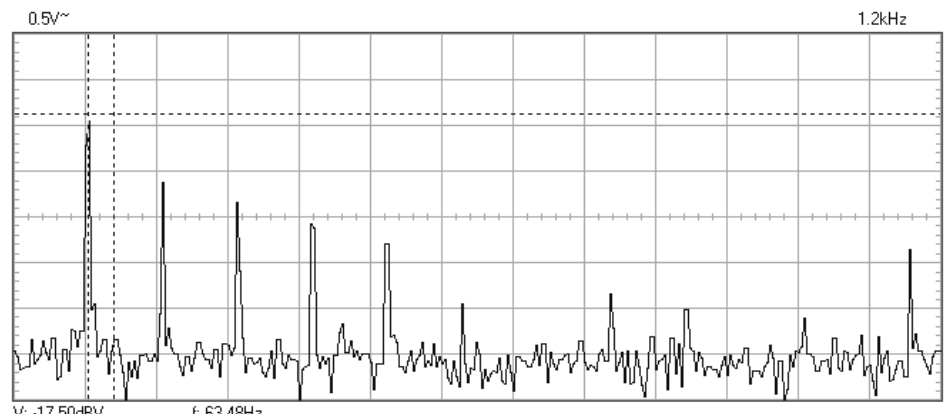
Figure 16. Frequency spectrum with the mass of 0.620 kg recorded after 141,000 cycles at 94 Hz. The frequency of the stress cycles was maintained at the value of 63.5 Hz for just 47,880 cycles until the vibration amplitude of the tested sample decreased very fast pro- ducing the breaking of it. Just before the end of the testing second stage, the last frequency response function was recorded at which the resonance regime could be obtained before breaking.